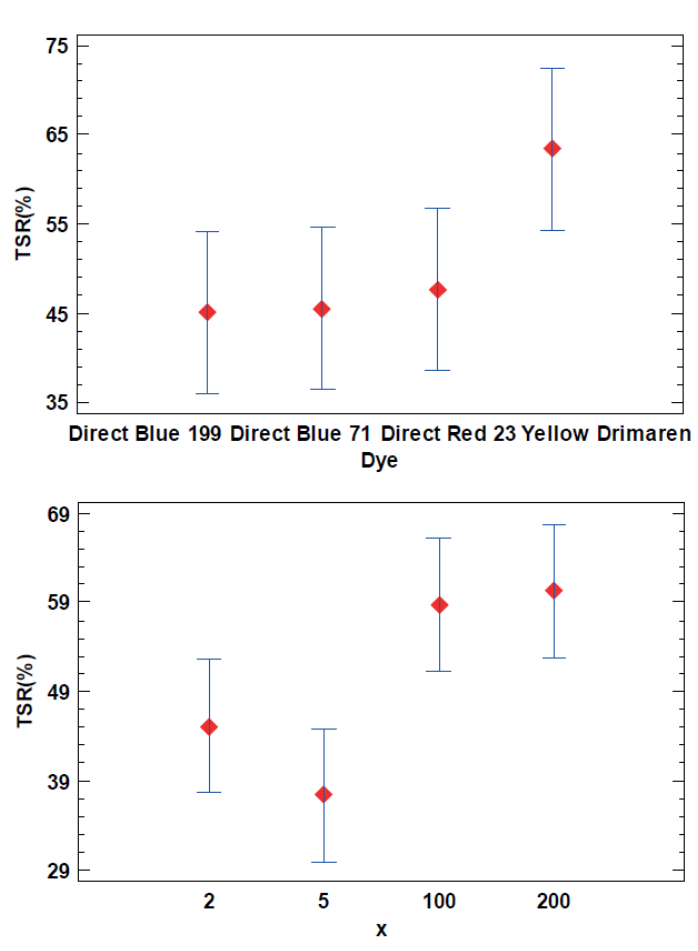
Figure 6. LSD Fisher means plot (95% confidence intervals) from TSR (%) as the response variable.